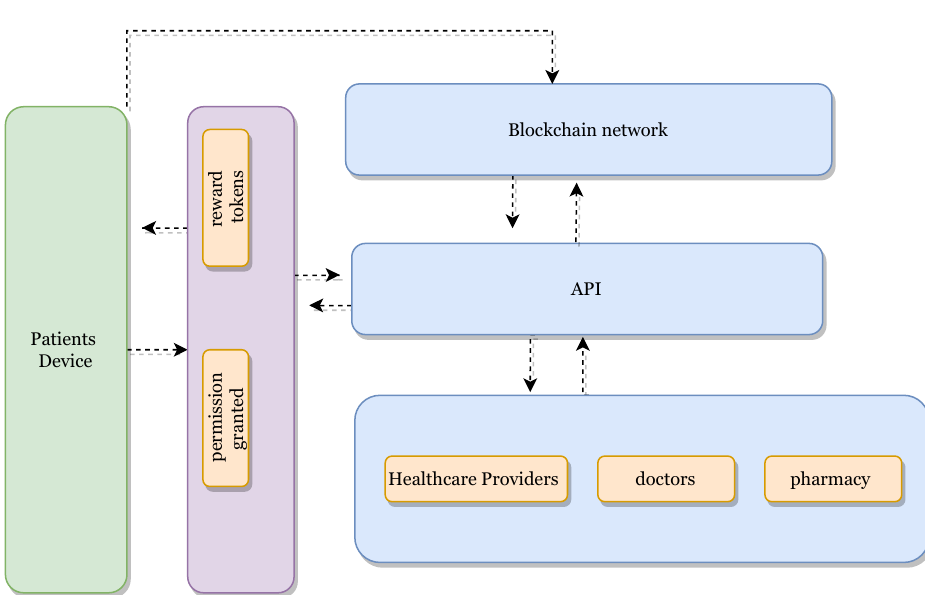
Figure 8. BlockPres incentive